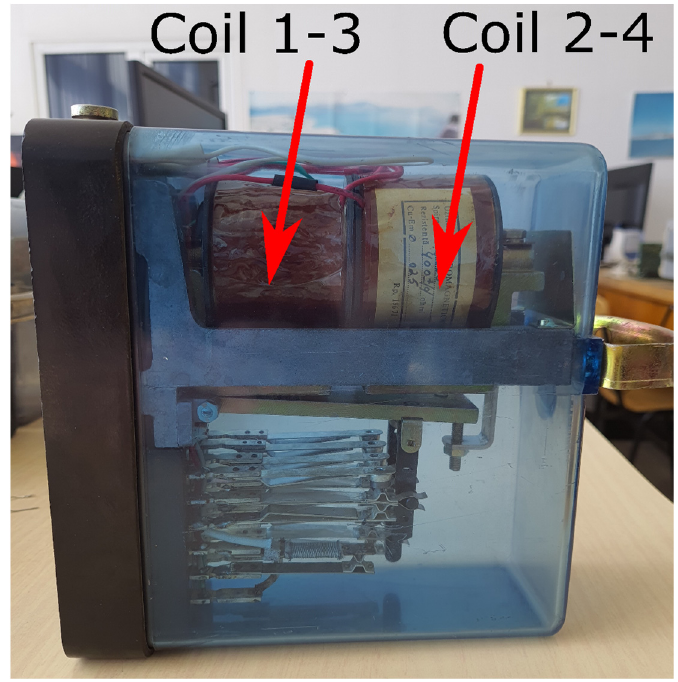
Figure 6. Typical arrangement of coils in an NF-1 800 relay.